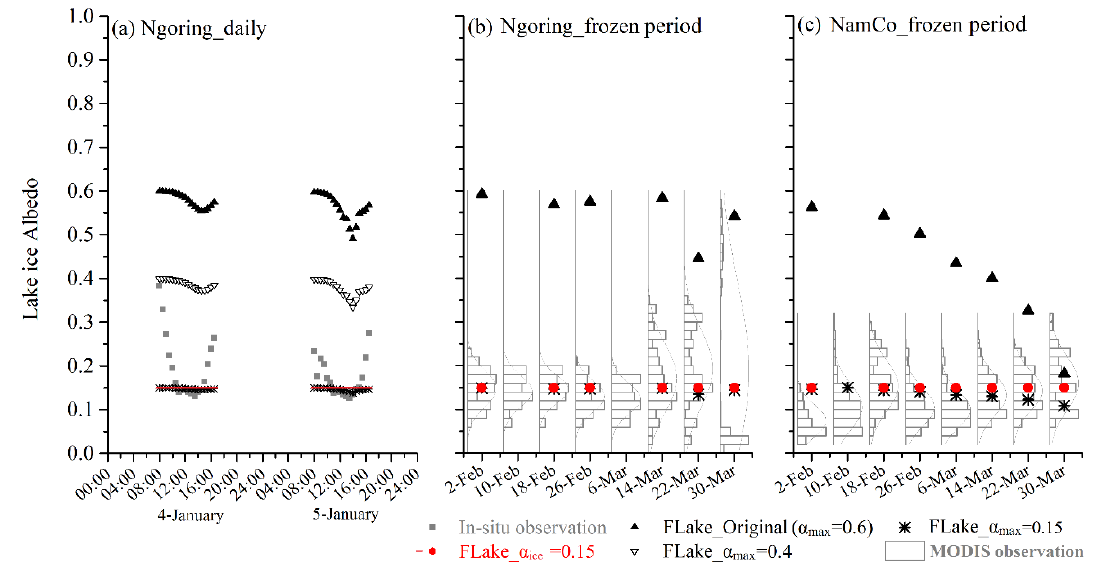
Figure 2. Lake ice albedo from the in situ and MODIS observations, and calculated using the different albedo parameterization schemes, at Lake Ngoring and Lake Nam Co for ( a ) 4 to 5 January 2014, and ( b , c ) 1 February to 31 March 2015. Time is shown in local time.